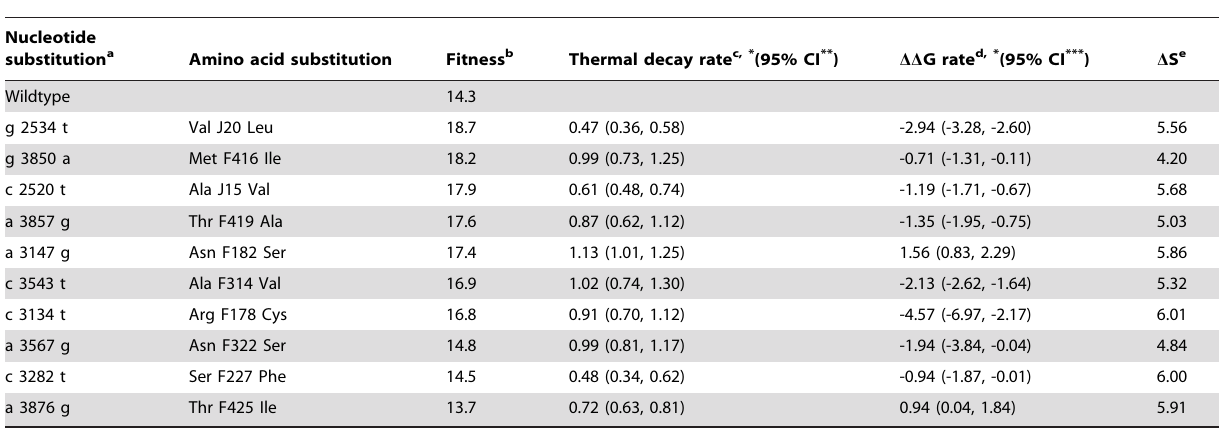
Table 1. Fitness, stability, and conformational entropy of single amino acid mutations.